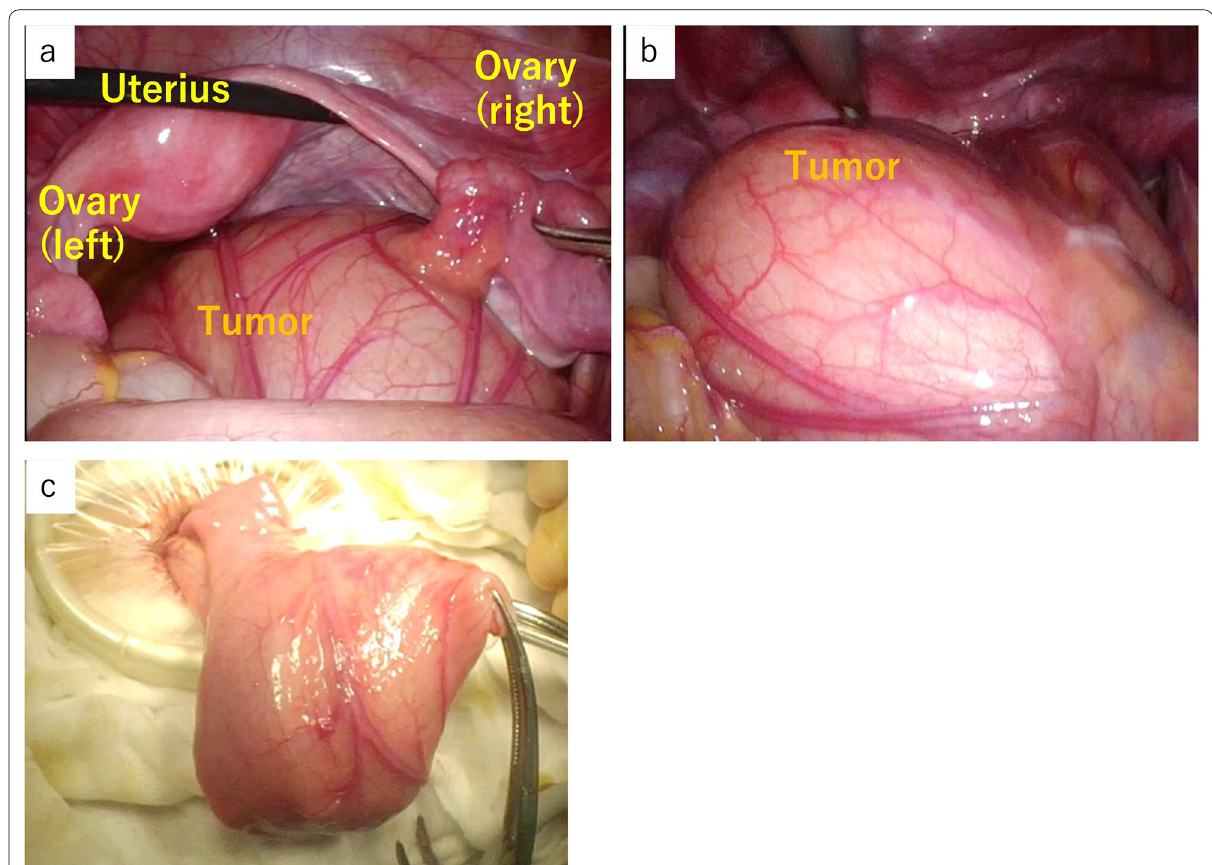
Fig. 3 Intraoperative laparoscopic view. The image shows a tumor as a lesion that fits into the pelvis ( a ). The lesion has good mobility without adhesions in the pelvis and can exit the body cavity from the umbilical region ( b , c ). The cystic tumor was located on the mesenteric side, approximately 40 cm proximal to the distal ileum. The boundary with the adjacent intestinal tract is unclear in the intraoperative findings, and partial resection of the small intestine containing the tumor was performed